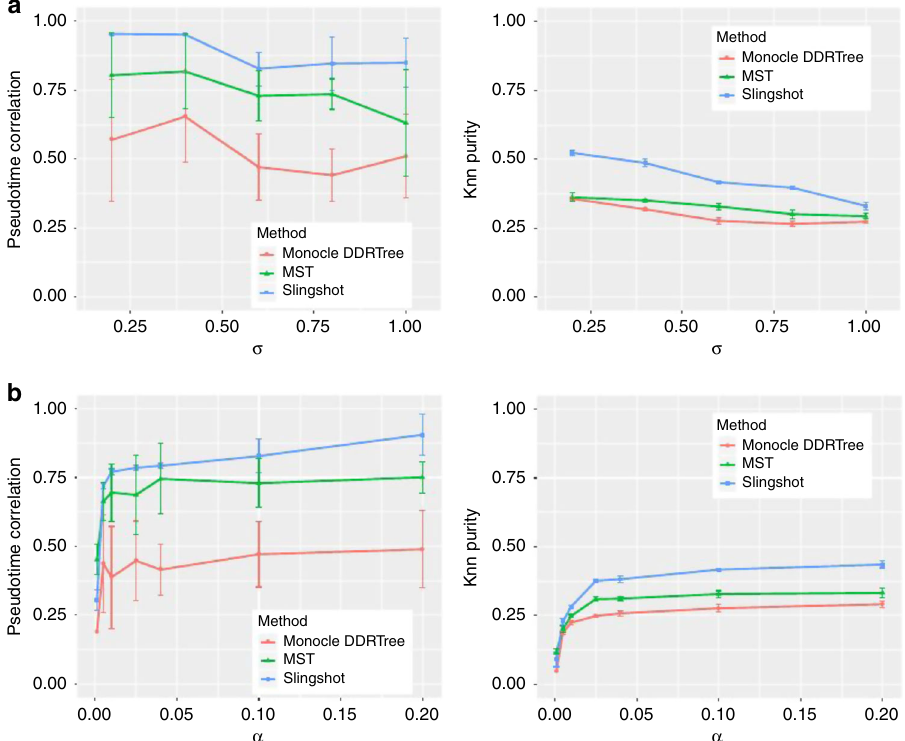
Fig. 7 Benchmark trajectory inference methods. a Pseudotime correlation and knn purity of all methods when varying σ ( α = 0.1). b Pseudotime correlation and knn purity of all methods when varying α ( σ = 0.6). Data used to plot a , b can be found in Source